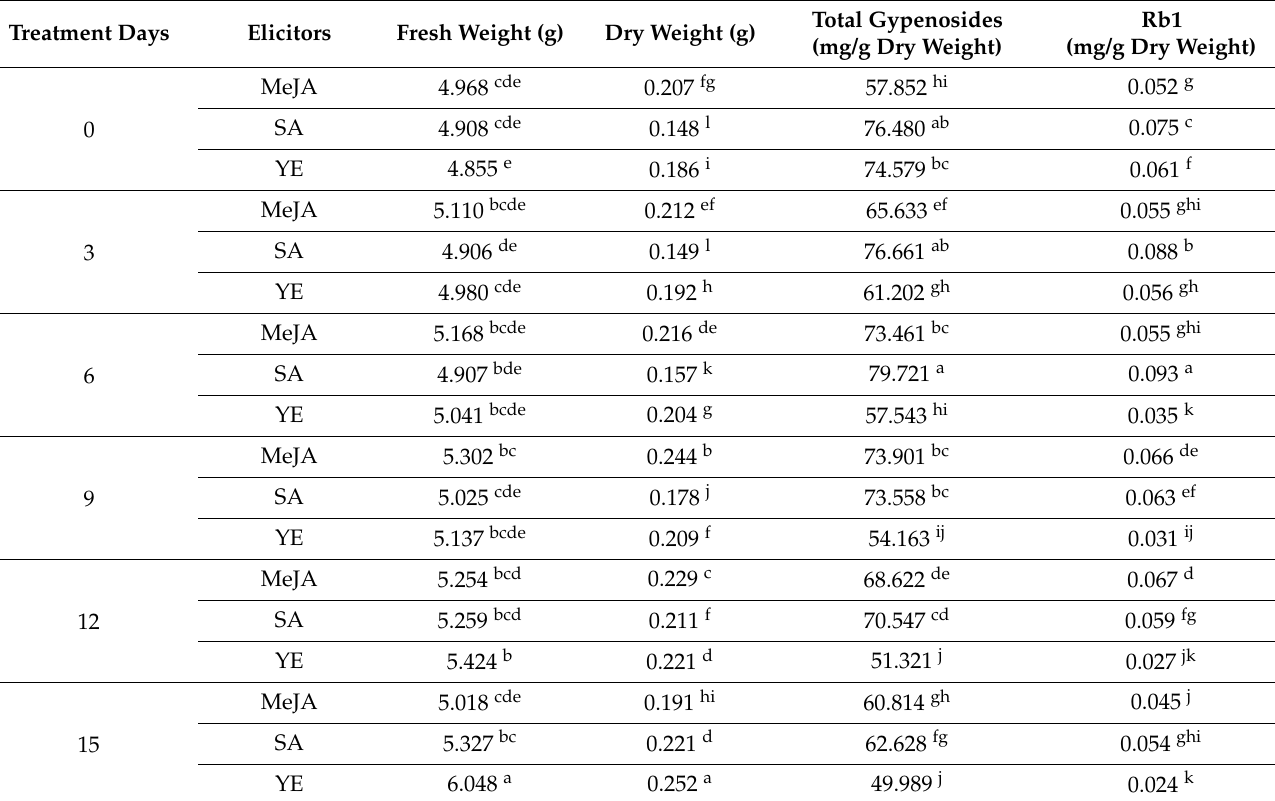
Table 3. Effect of elicitation times on the cell growth and gypenosides accumulation.